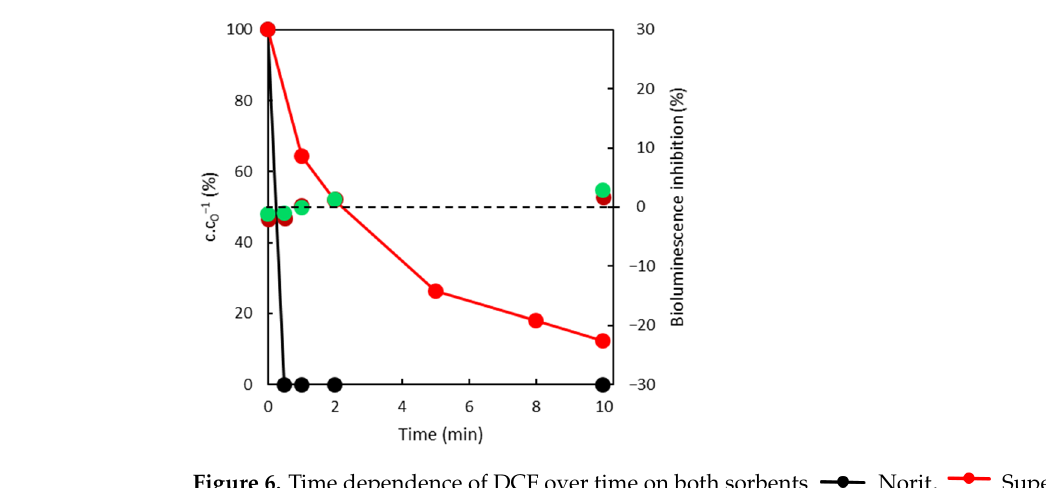
Figure 6. Time dependence of DCF over time on both sorbents Norit, SuperSorbon (left axis—normalized concentration (%); right axis—inhibition of bioluminescence ● after 15 min and ● after 30 min).